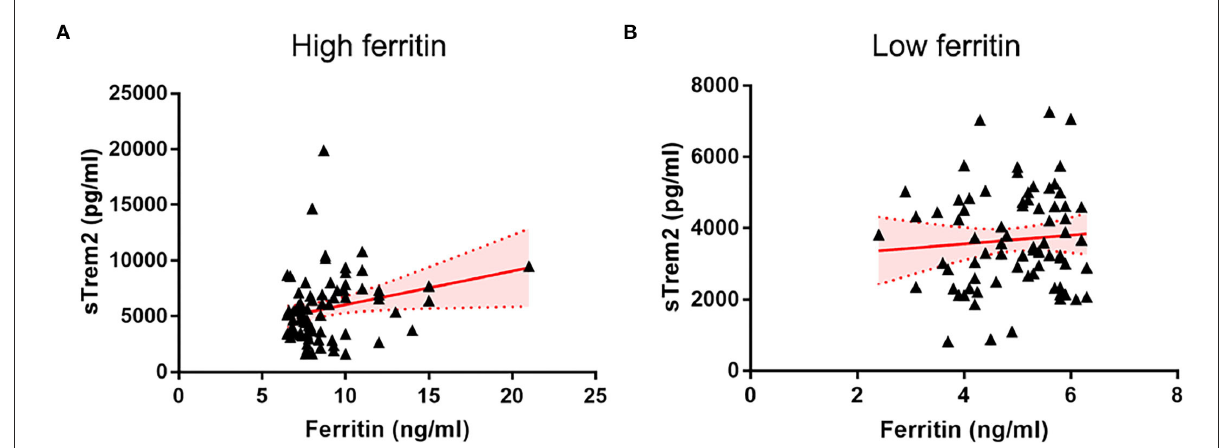
FIGURE2 The associations of CSF ferritin with sTrem2 among participants with high (A) and low (B) CSF ferritin. CSF, cerebrospinal fluid.